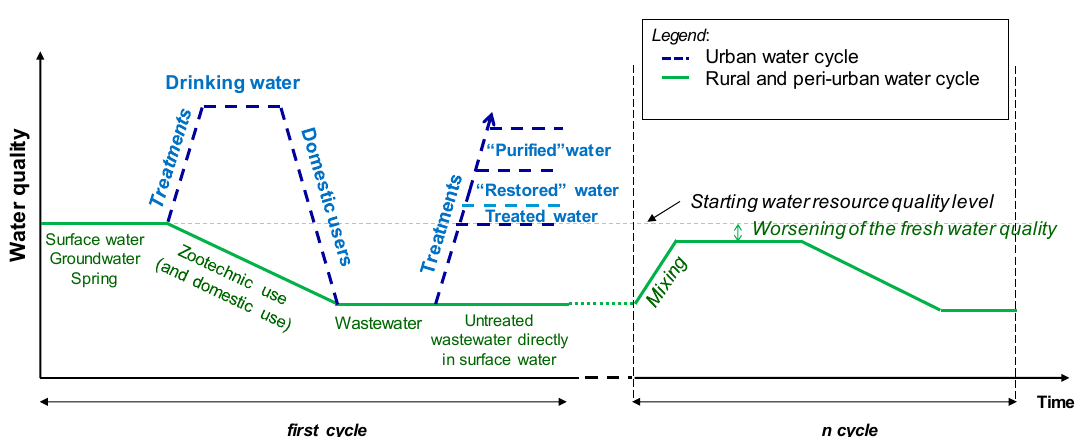
Figure 10. Water quality versus time in the case of inadequate treatments are present for wastewater produced by anthropic activities. The dashed line refers to the case in which treatment is present and properly works. The graph reports two “cycles” (cycle 1 and n) occurring over two periods in the same place where no wastewater treatments are present, thus the quality of the surface water receiving the untreated wastewater gets worse and worse.